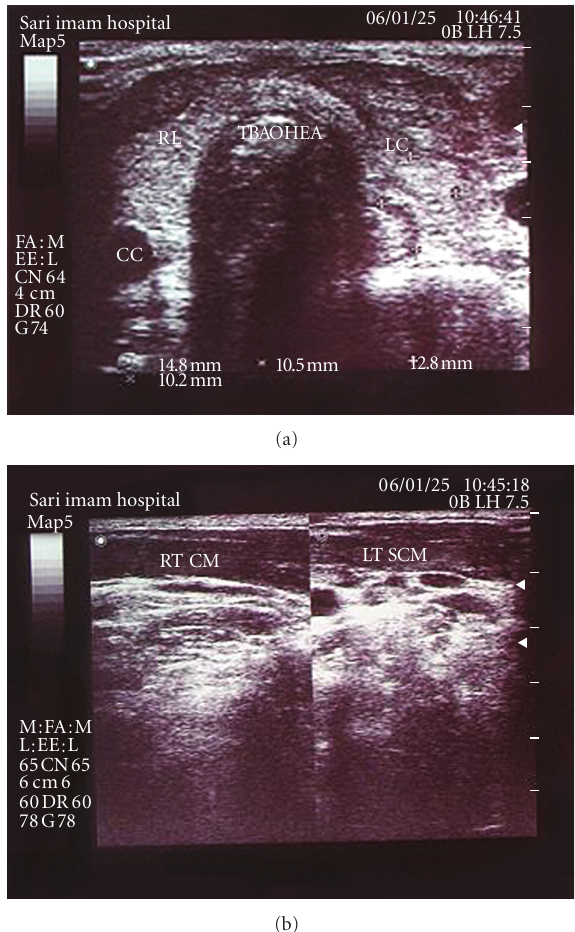
Figure 2: Second sonography findings in the second case.